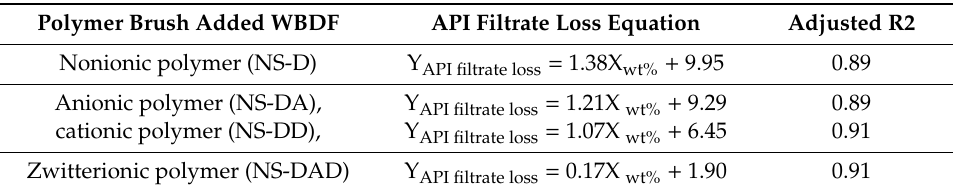
Table 3. Regression analysis of API filtrate loss of water-based drilling fluid system (WBDF) after adding di ff erent types of polymer